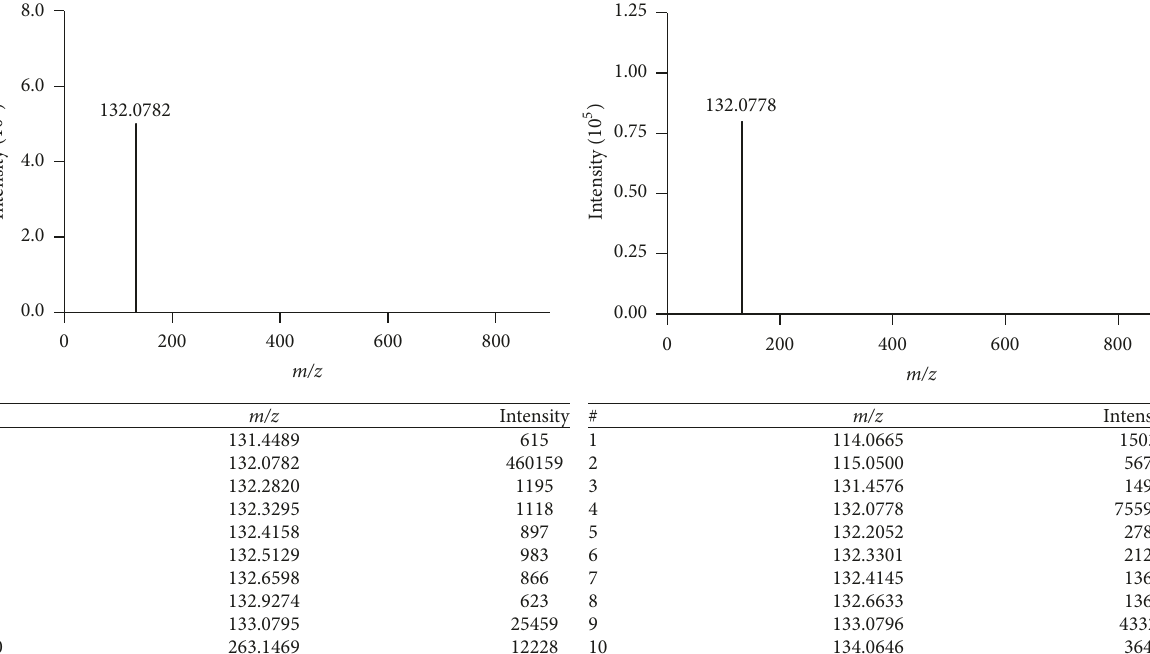
Figure 4: The 𝑚/𝑧 and intensity value of creatine on day